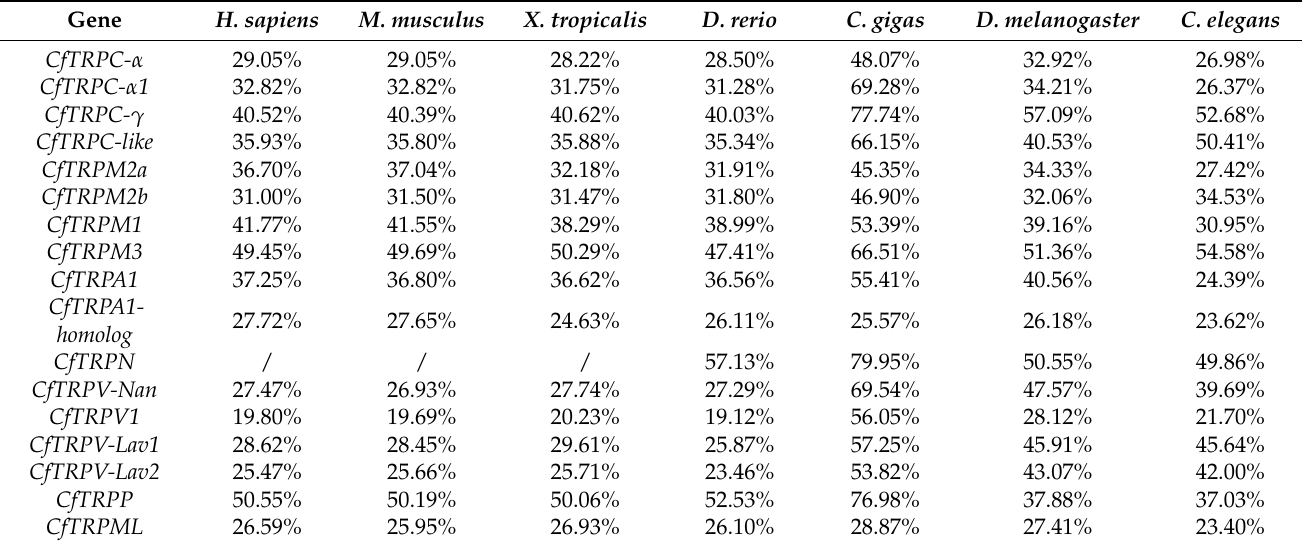
Table 3. Percentage of Identity(I) of CfTRPs with selected TRP proteins in other species. Gene H.